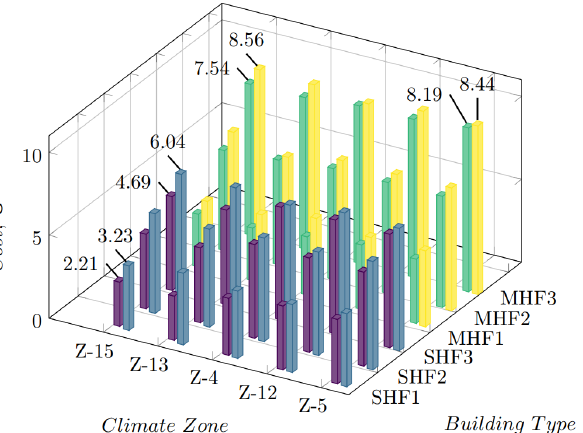
Figure 12. Cost comparison between full-load (left column, purple and green) and partial-load operation (right column, blue and yellow) for different climate zones and building types, for a USB typical day (intermediate season, weekend day,